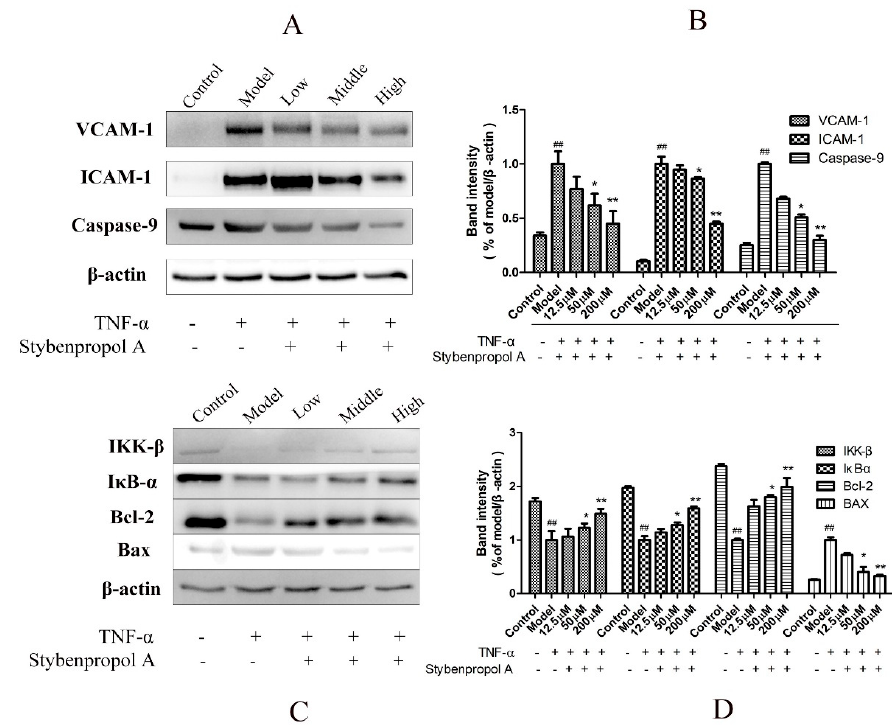
Figure 7. Stybenpropol A modulated apoptosis-related protein expression and downregulated NF- κ B nuclear transcription. Following a 24-h pretreatment with stybenpropol A (12.5, 50, 200 µ M), HUVECs were treated with TNF- α and then Western blotting was used to measure protein levels ( A , B ). Quantification of protein levels ( C , D ). Data are means ± SD of three independent experiments. ## p < 0.01 vs. control; ∗ p < 0.05, ∗∗ p < 0.01 vs. model group.